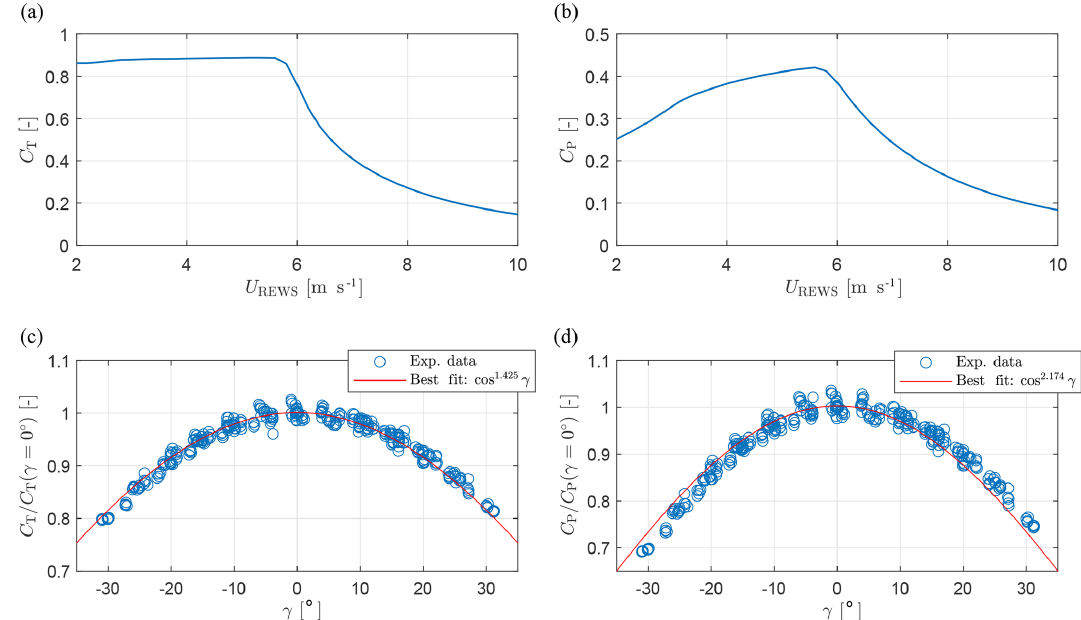
Figure 2. C T (a) and C P (b) vs. rotor-equivalent wind speed U REWS . C T (c) and C P (d) vs. misalignment angle γ .